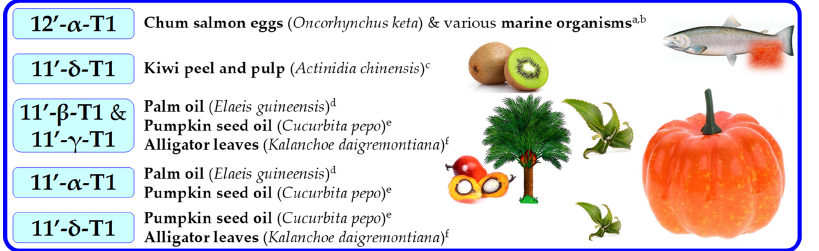
Figure 8. Chemical structure of tocomonoenols and tocodienols. For α-, β-, γ-, δ- methyl substituent number and position see Figure 1.